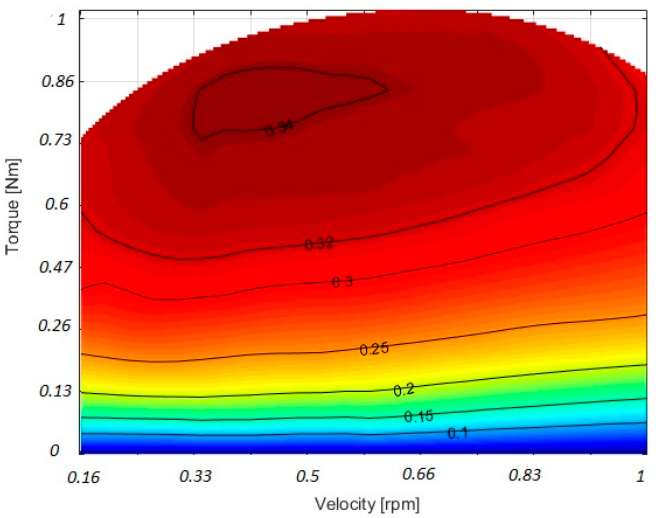
Figure 3. ICE efficiency contour map.